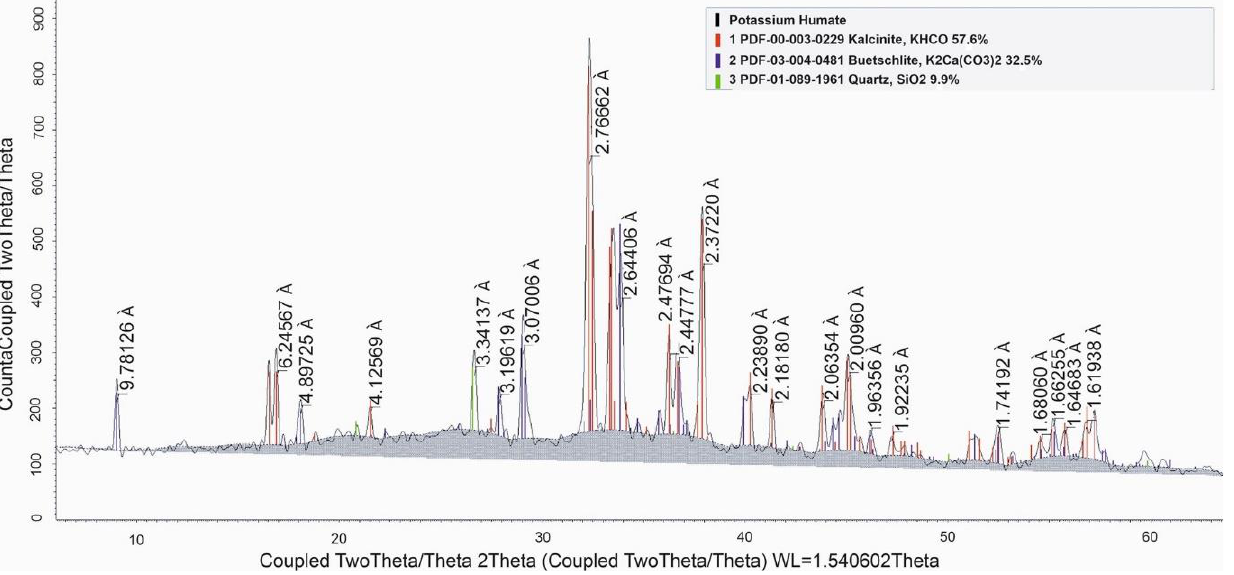
Figure 11. Results of X-ray diffraction analysis of potassium humate.